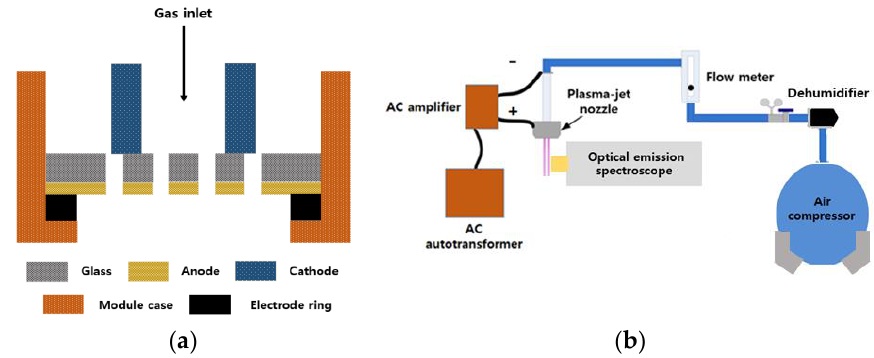
Figure 1. Nonthermal atmospheric-pressure plasma-jet system. ( a ) Structure of the micro plasma-jet nozzle. ( b ) Experimental set-up for discharge experiments.